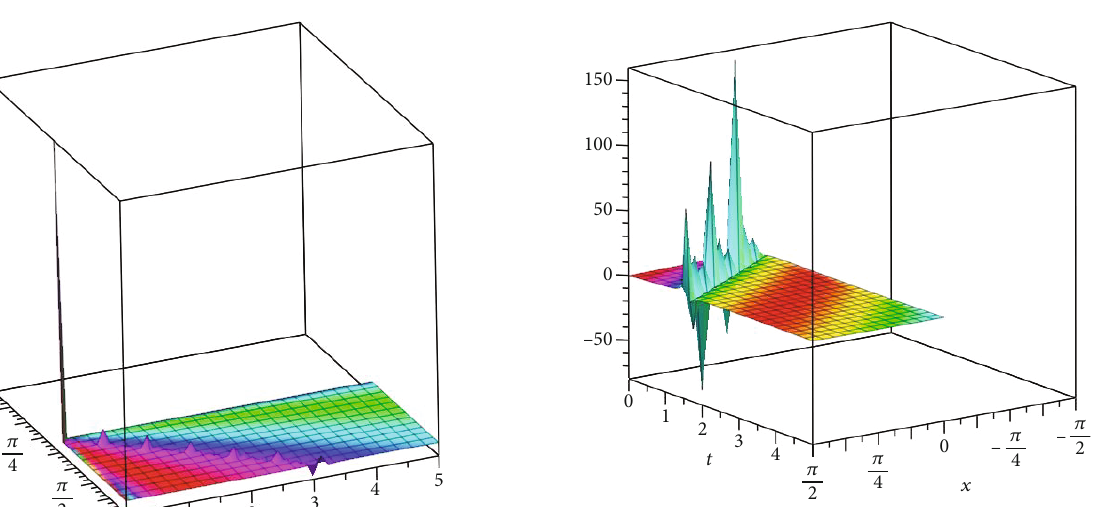
Figure 7: Graphical representation of solution u (29) for t = 0 :: 5, x = − π :: π , for α = 0 : 8 . ð x , y , t Þ given by 2